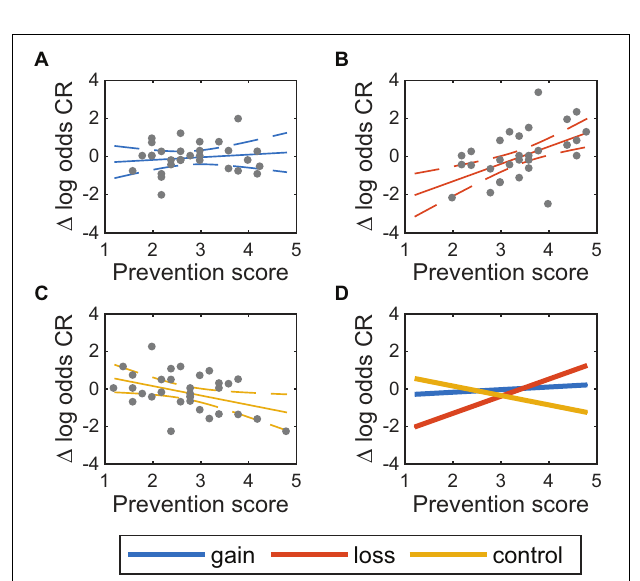
FIGURE 5 | Change in correct rejection rate varies with prevention score. Change in log odds correct rejection (CR) is shown vs prevention score for (A) gain condition, n = 31, (B) loss condition, n = 30, and (C) control condition, n = 32. Solid lines show the expected mean, and dashed lines show a 95% confidence region around the expected mean. (D) Expected means for all three conditions.